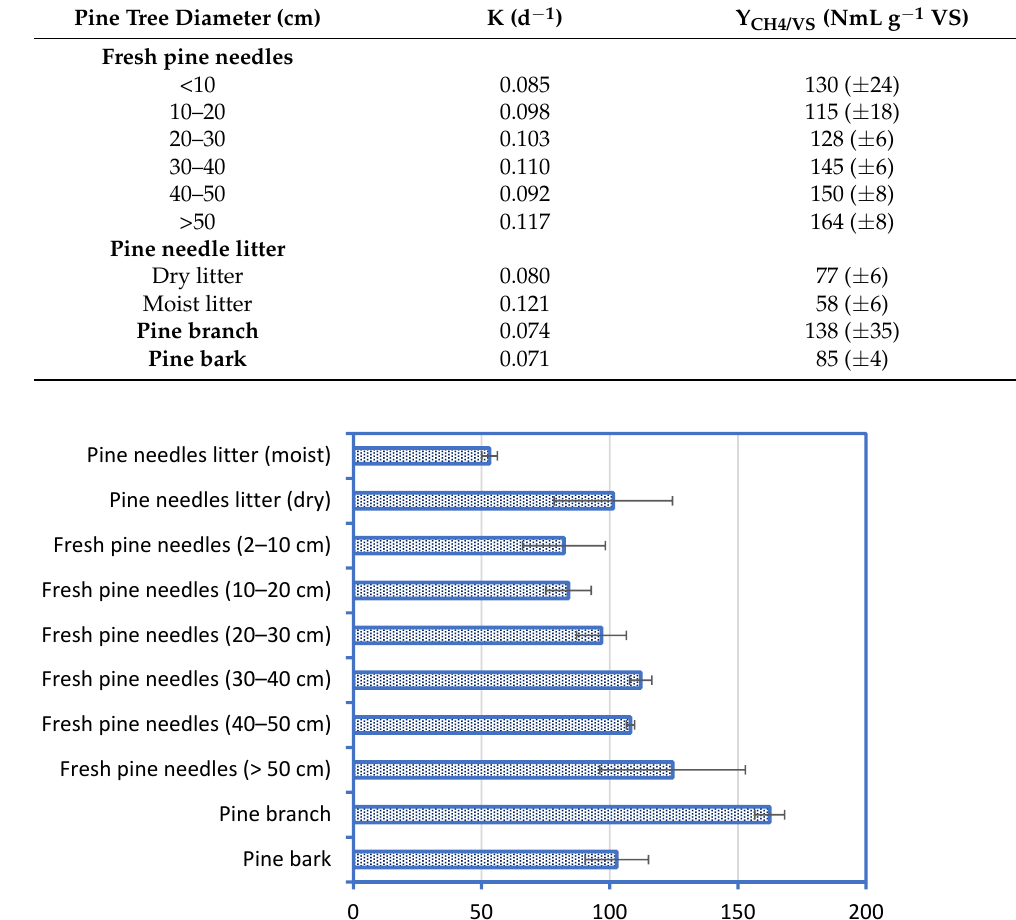
Table 2. First-order kinetic constants and methane yield for fresh pine needles, pine needle litter, pine bark, and pine branches.